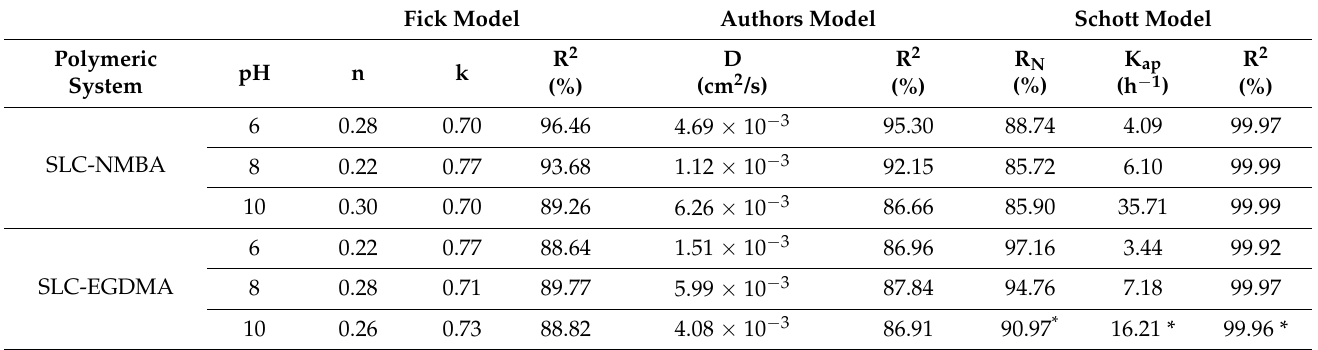
Table 6. Parameters related to nitrate diffusion mechanism for the Fick, Authors, and Schott Models. Fick Model Authors Model Schott